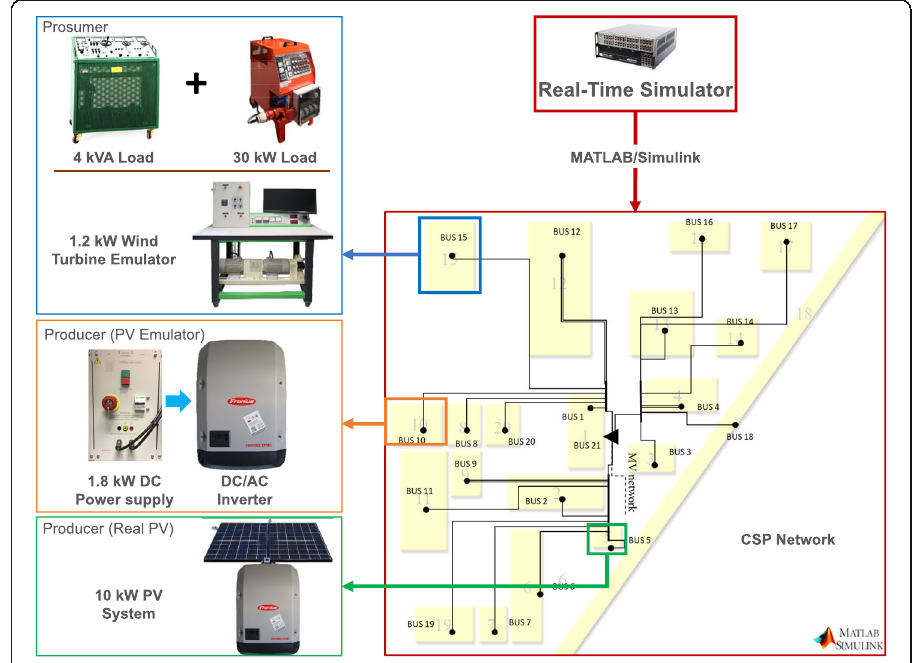
Fig. 2 Real and laboratory HIL equipment in MATLAB/Simulink CSP